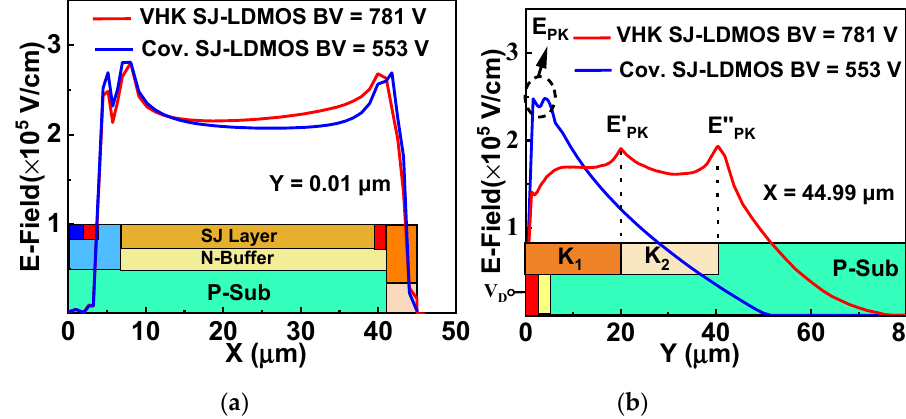
Figure 4. ( a ) Lateral electric field distributions for the conventional SJ-LDMOS and VHK SJ-LDMOS in the middle of the N-pillar along the X-direction, ( b ) vertical electric field distributions for the two devices perpendicular to the drain at X = 44.99 μ m.